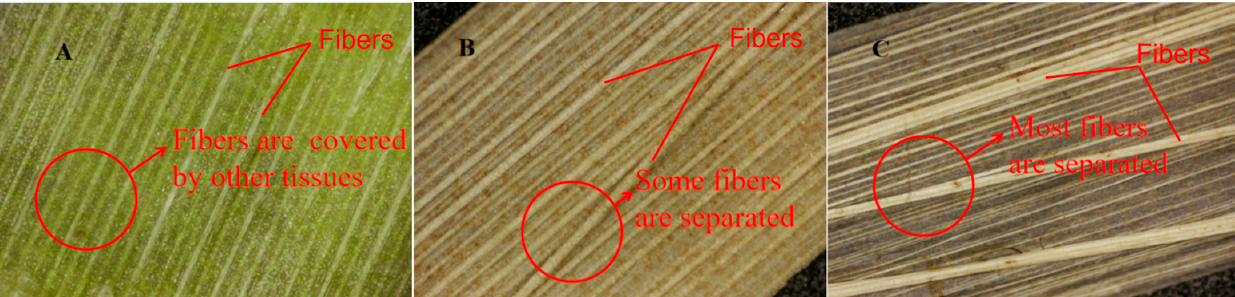
Figure 9. Microscopic image of banana stem outer skin ( A ) 5 days of retting with warm water; ( B ) 15 days of retting with warm water; ( C ) 25 days of retting with warm water.